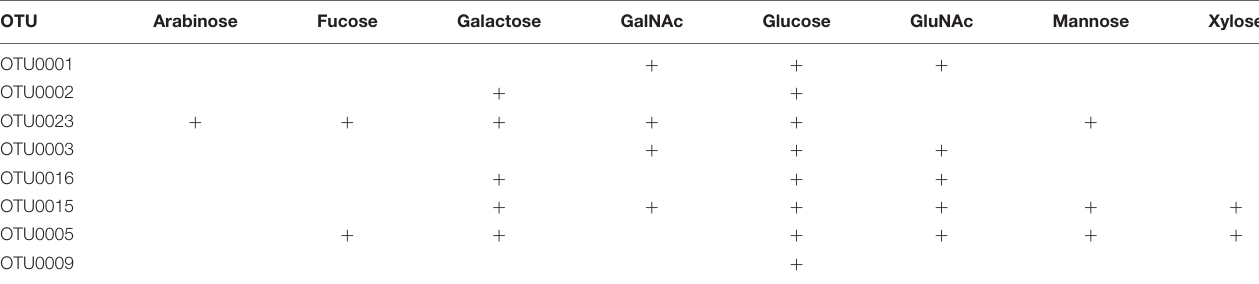
TABLE 1 | (B) Affiliation of bacterial sequences retrieved from coral mucus samples and their potential enzymatic activities on various sugar. OTU Fucose Galactose GalNAc Glucose Mannose